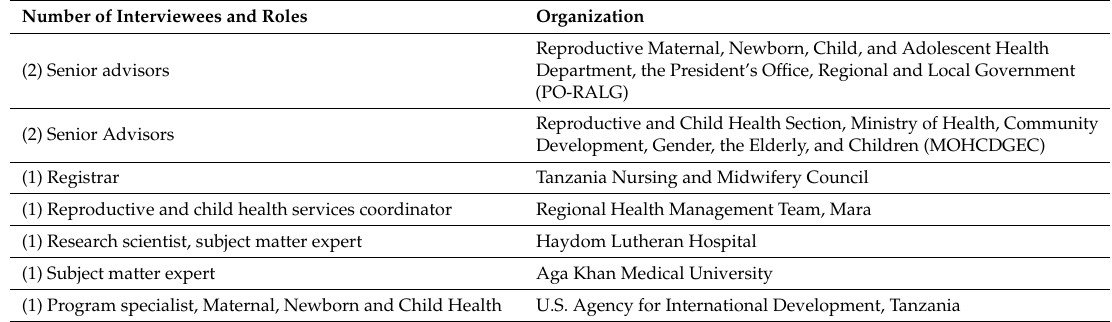
Table 1. Study participants.